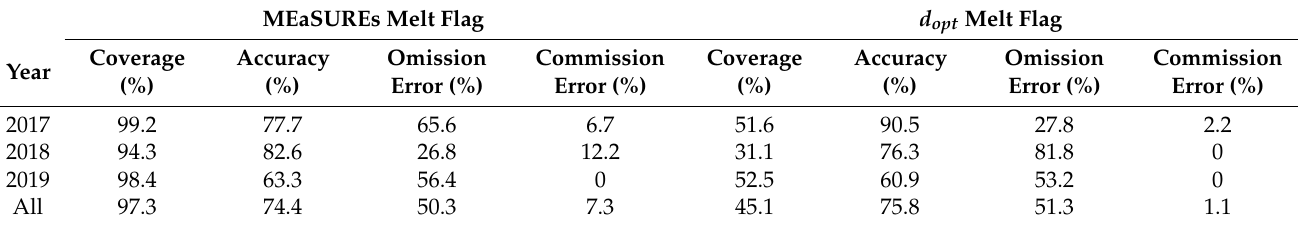
Figure 8. Comparison of three melt flags at KAN_U: (i) from MEaSUREs dataset; (ii) derived from a 0.64 mm threshold on the retrieved snow optical grain diameter ( d opt ); and (iii) derived from the energy budget at the KAN_U AWS. The melting/nonmelting binary flag is shown in the upper part of each panel while retrieved snow optical grain diameter (purple dots), its 0.64 mm threshold value (dashed gray line) and the hourly AWS-derived melt (red line) are shown in the lower part of each panel. Table 3. Comparison statistics of d opt -based and MEaSUREs melt flags. AWS-derived daily melt greater than 1 mm w.e. is taken as ground reference. The coverage is the fraction of days between 1st May and 30th of September for which a flag value is available. The accuracy is the fraction of days correctly classified by a flag. The omission error is the fraction of true melt days not detected by a flag. The commission error is the fraction of nonmelt days classified as melt by a flag.